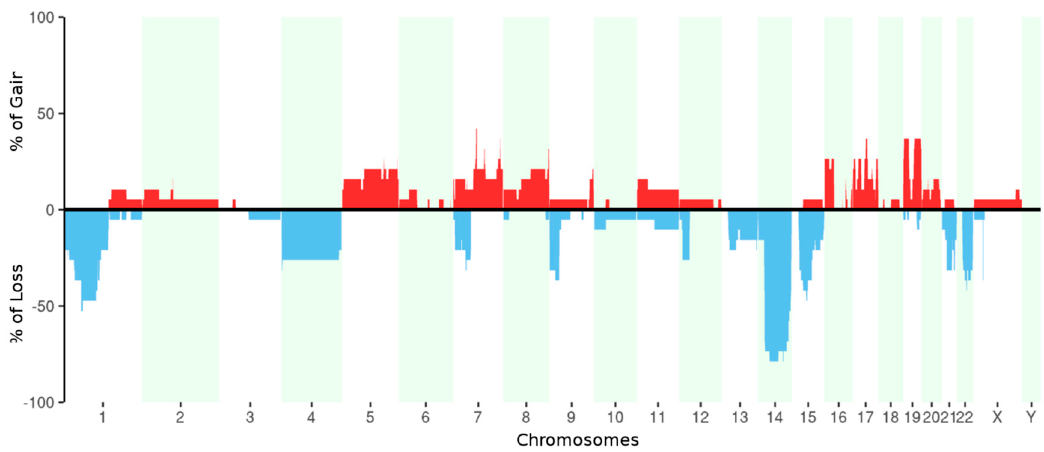
Figure 3. Graphic representation of clonal evolution of metastatic tumors T07–11 and T04–05. The full filled squares indicate the somatic mutations in the corresponding gene (blue and pink respectively for patient P06 and P04).